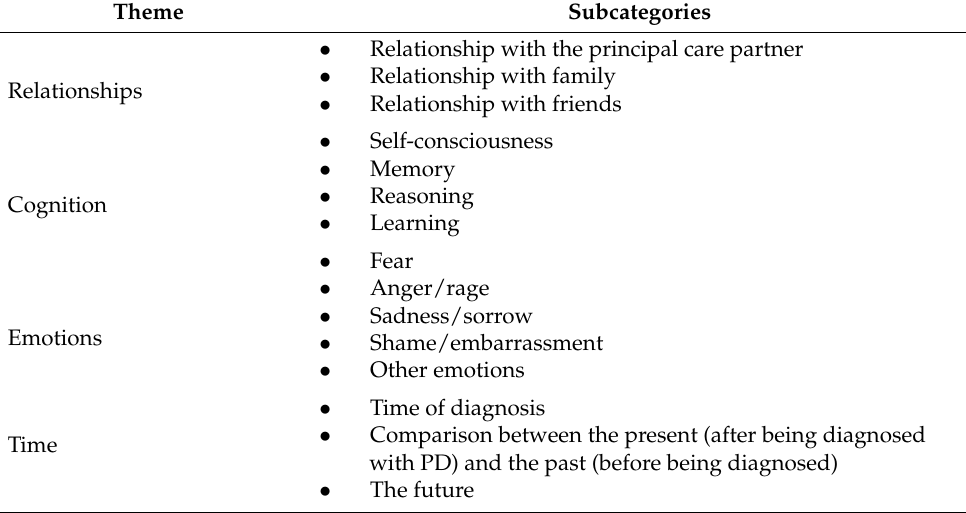
Table 2. Themes used for Content